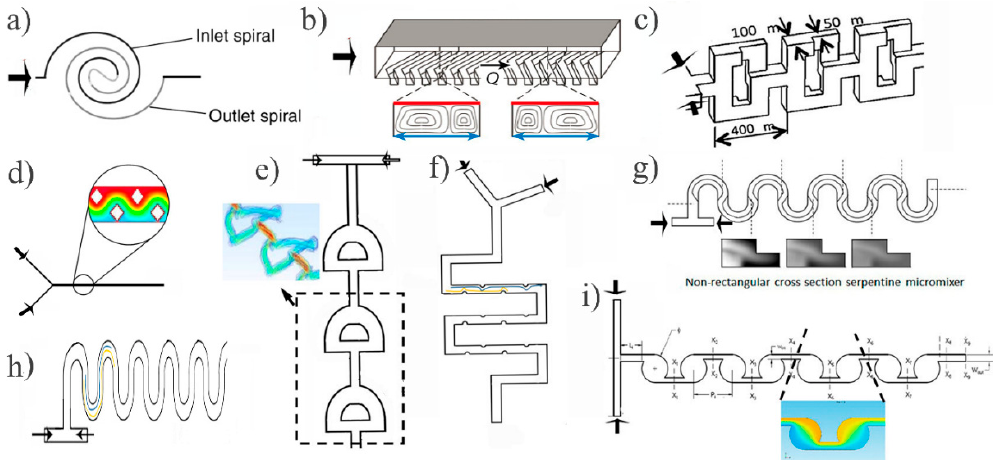
Figure 1. Various passive mixing enhancement designs. ( a ) Sketch of spiral microchannels; reproduced with permission from [29], published by the Royal Society of Chemistry, 2006. ( b ) The popular staggered herringbone; reproduced with permission from [41], published by The Royal Society, 2004. ( c ) The baker’s transformation; reproduced with permission from [42], published by Elsevier, 2017. ( d ) Example of obstacles placed in the fluid path stream; adapted with permission from [33], published by IOP Publishing, 2007. ( e ) The 3D “fishbone”-like design; adapted from [39] under a Creative Commons BY license, published by AIP, 2016. ( f ) Serpentine with added circular features inside the microchannel, ( g ) The 3D serpentine, adapted from [43] under a Creative Commons BY license, published by MDPI, 2018. ( h ) A simple serpentine structure. ( i ) A custom mixing design for Re = 1; reproduced with permission from [38], published by Springer Nature, 2017.